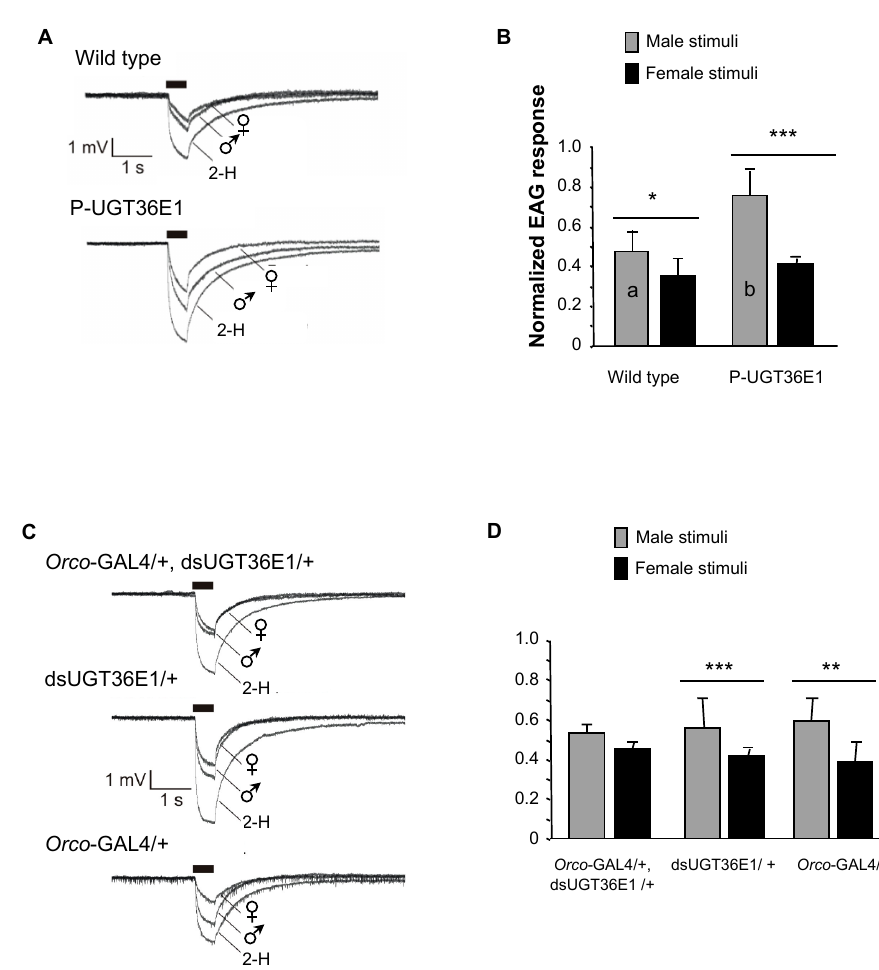
Figure 4. Electrophysiological recording of male olfactory response to di ff erent stimuli. ( A ) The graphs represent averaged electroantennogram (EAG) responses of wild-type and P-UGT36E1 mutant male flies to three stimuli: living females, living males and 2-Heptanone (2-H). The thick bars indicate the stimulus duration. ( B ) Bars represent the EAG responses to males and females normalized with the respective responses to 2-H. Statistical di ff erences were noted (i) for the significance of the di ff erence to both sex stimuli (above each pair of bars) and (ii) for responses to male stimuli (letters inside lightly filled bars), between genotypes. ( C ) Averaged EAG responses for “ Orco -GAL4 /+ , dsUGT36E1 /+ ”, “dsUGT36E1 /+ ” and “ Orco -GAL4 /+ ” males presented with the same three stimuli. ( D ) Normalized EAG responses to males and females. “ Orco -GAL4 /+ , dsUGT36E1 /+ ” males showed no di ff erence in their responses to either sex. For each test, n > 11. For statistics and conditions, see Figure 1. *** p < 0.001; ** p < 0.01; * p < 0.05.